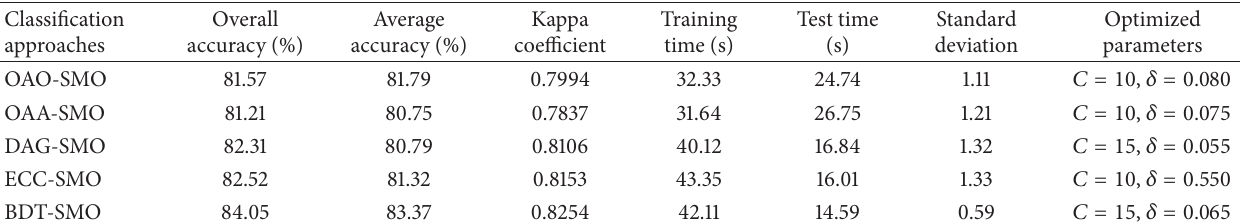
Table 5: Comparison of classification results under different SMO multiclass classification approaches (zone 2). Classification